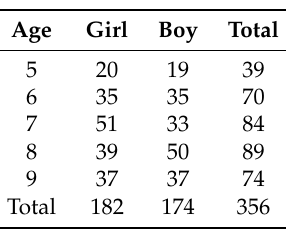
Table 4. Number of